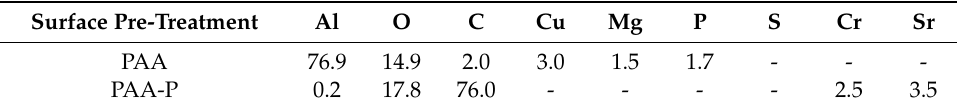
Table 4. Average chemical composition (in wt %) of the PAA and PAA-P pre-treated AA2024-T3 surface before aging by EDS